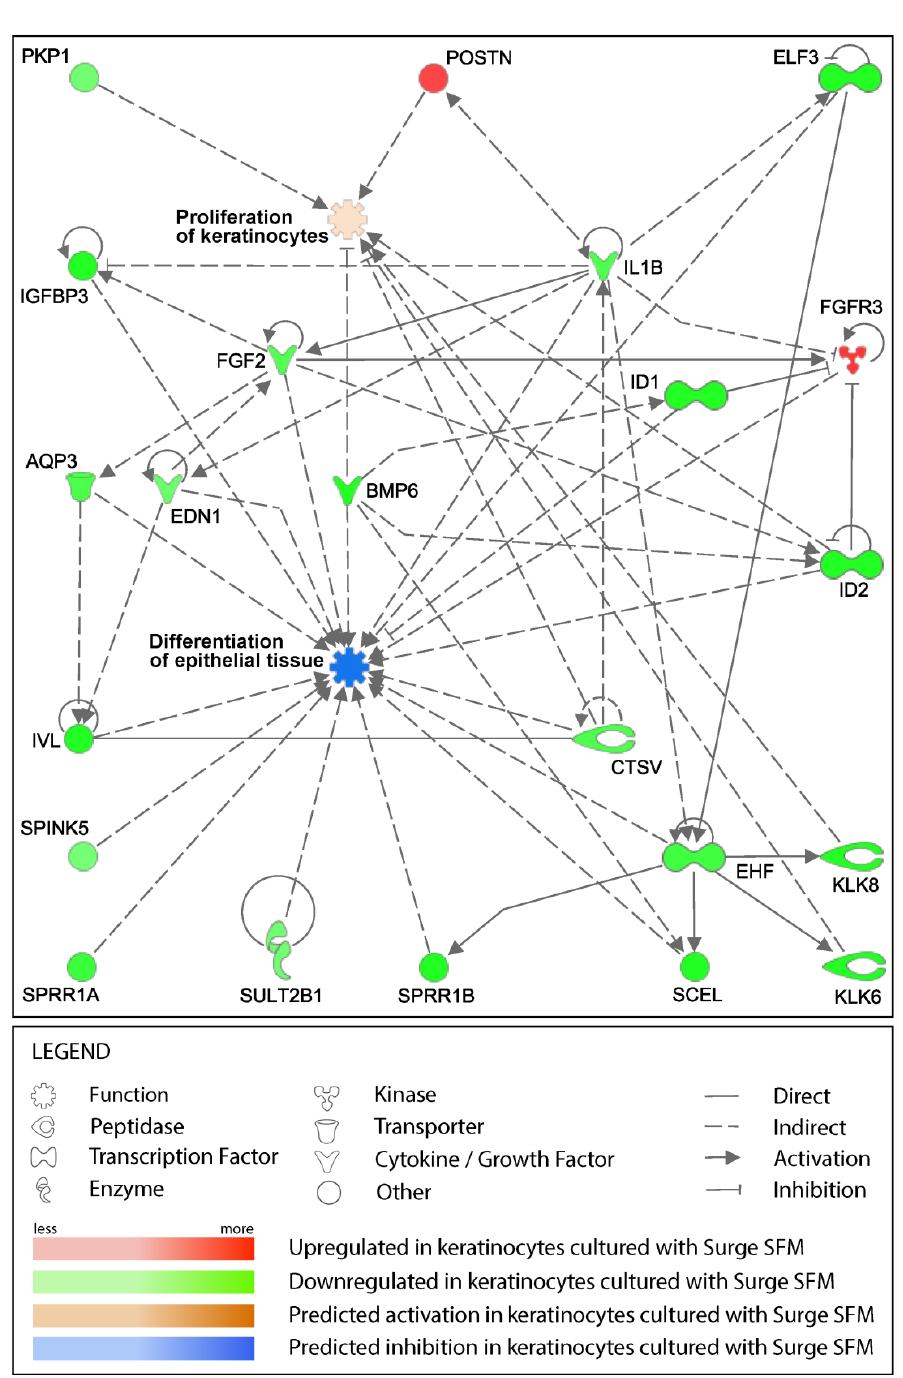
Figure 5. Gene–gene and gene–function interaction network built around the two biological functions of interest, “Proliferation of keratinocytes” and “Differentiation of epithelial tissue”, using the gene expression differential analysis data.